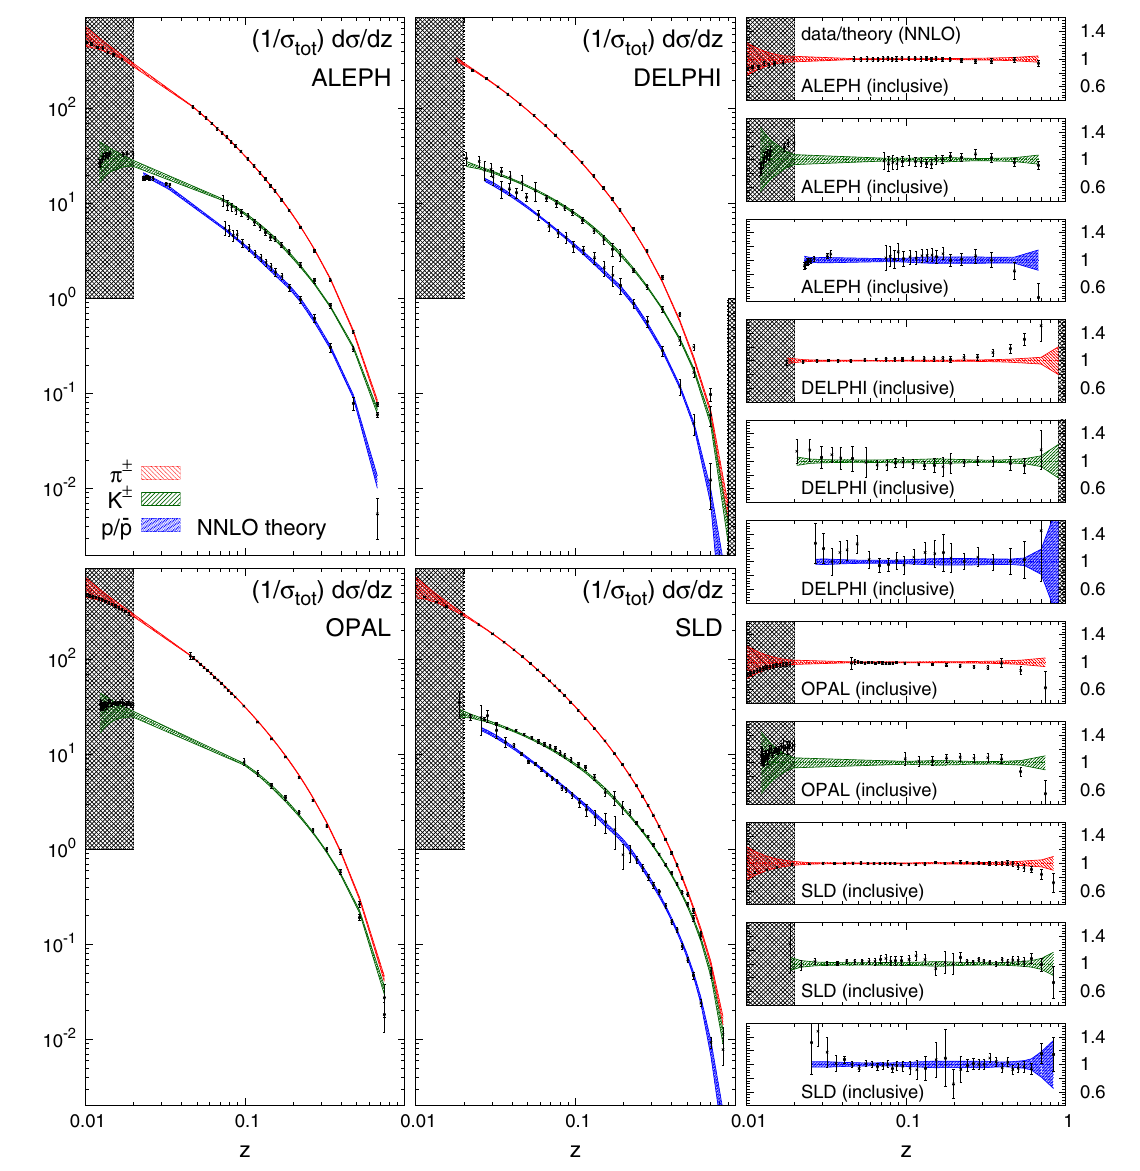
Fig. 5 Same as Fig. 4 for the ALEPH, DELPHI, OPAL and SLD inclusive measurements